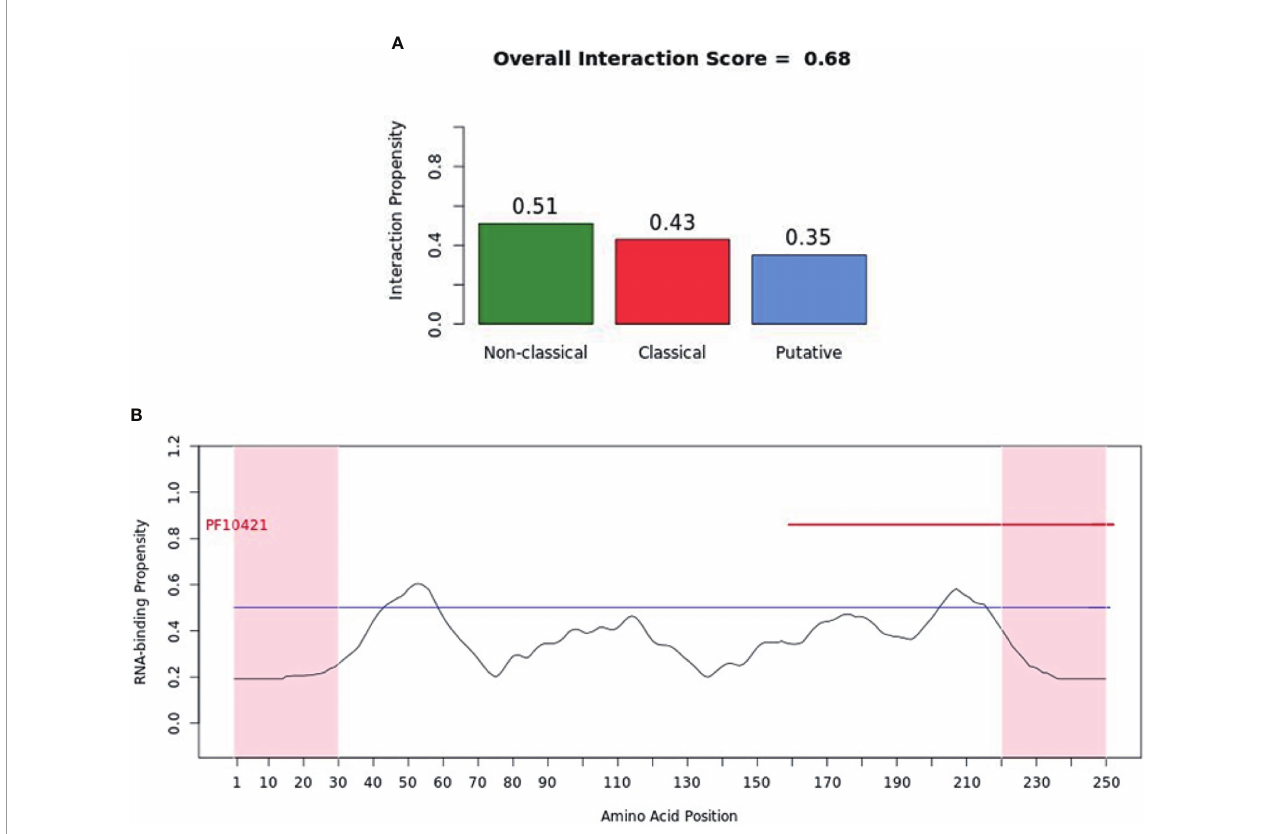
FIGURE 5 | RNA-binding ability of murine-2 ’ -5 ’ -OAS1 predicted by catRAPID signature. (A) The propensity of murine-2 ’ -5 ’ -OAS1 for the nonclassical (0.51), classical (0.43) and putative (0.35) RBPs. The overall interaction score (0.68) for murine-2 ’ -5 ’ -OAS1 as an RBP was also present. (B) The pro fi le shows protein regions and their propensity to interact with RNA. The catRAPID signature correctly identi fi es the RNA binding domain of murine-2 ’ -5 ’ -OAS1, which carries the region of enzymatic activity between 320 and 344 at the extreme C-terminal end